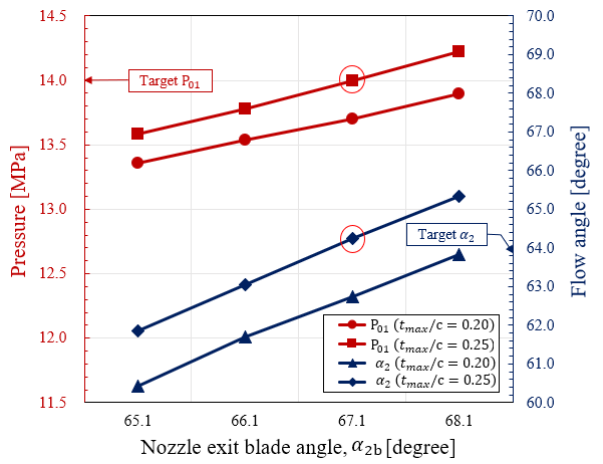
Figure 10. Pressure ( 𝑃 01 ) and flow angle ( 𝛼 2 ) according to the first-stage nozzle optimization of the radial outflow turbine.